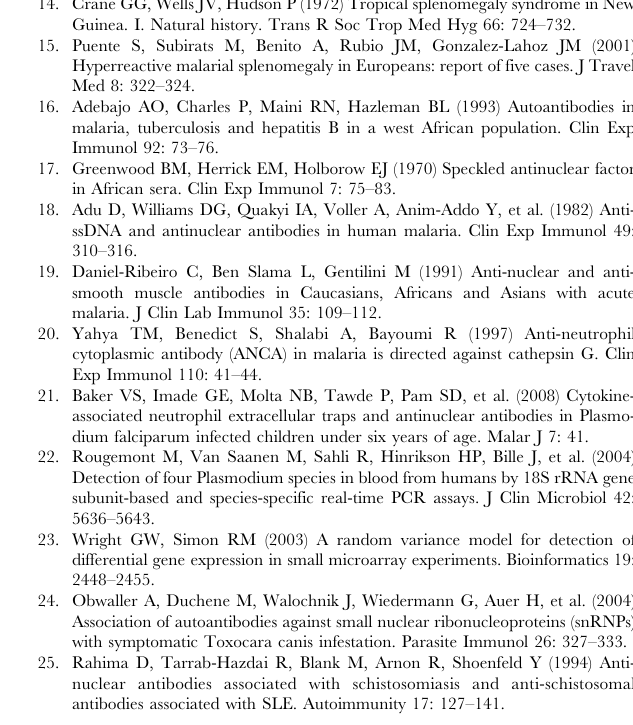
(TIF) Figure S2 Malaria autoantibodies are of IgG isotype. Malaria related pattern on HEp-2 cells obtained with the whole serum (left) and corresponding isolated IgG (right). Representative results of five patients are shown. (TIF) Table S1 ANA testings on HEp2000 cells of sera from patients with schistosomiasis, toxocarosis, leishmania- sis, filariasis or leishmaniasis. Table S2 Homology of autoantigens recognized by malalarial autoantibodies with plasmodial antigens using BLAST